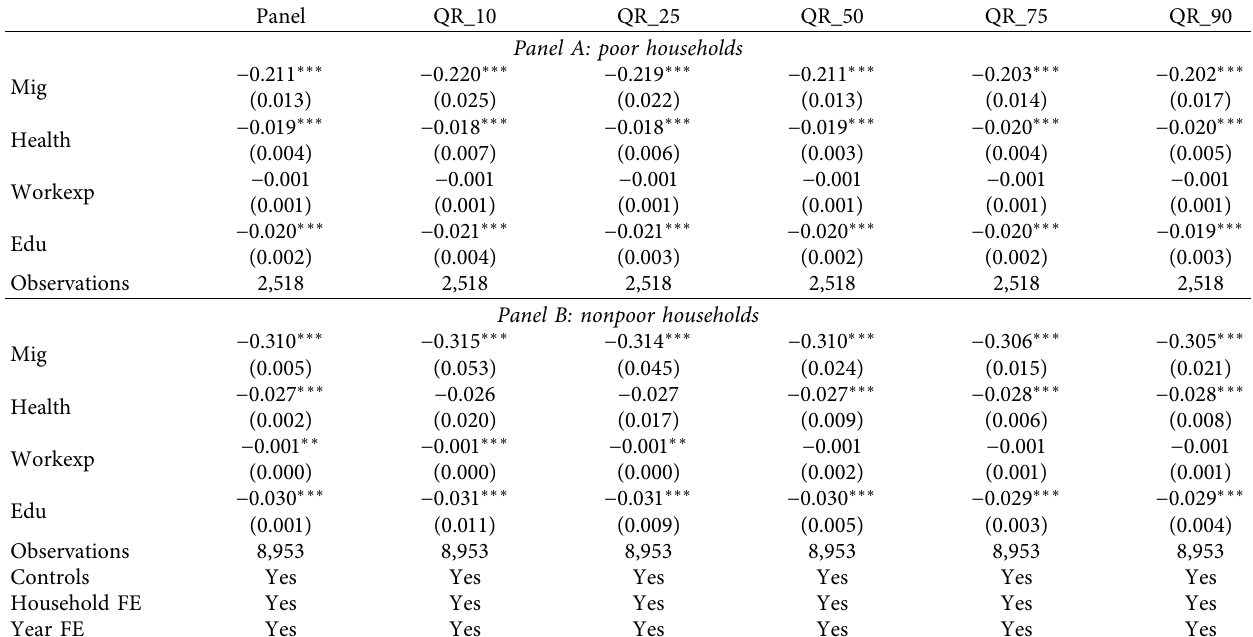
Table 4: Impact of human capital on vulnerability to relative poverty by poverty status.